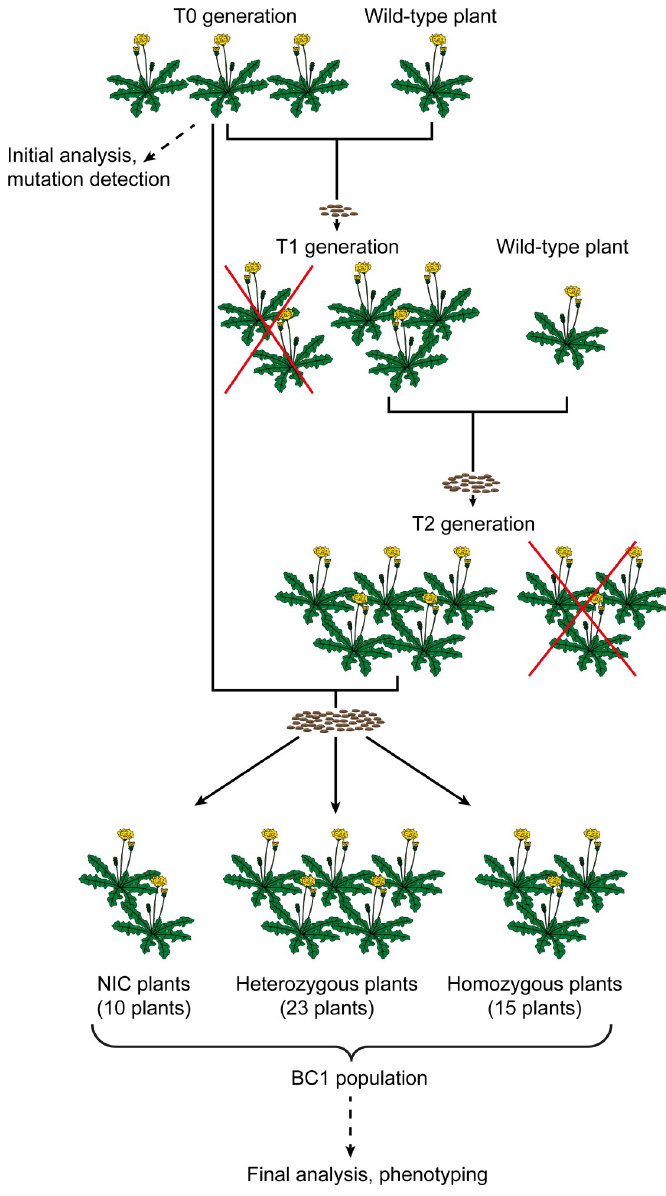
Fig 5. Crossing scheme for the generation of the backcross population. T0 plants were generated by stable Agrobacterium -mediated transformation, genome editing was analysed and plants were subsequently pollinated with a compatible T . koksaghyz wild-type plant, resulting in T1 plant families. T1 plants carrying desired mutations (not segregated out) were pollinated with another compatible T . koksaghyz wild-type plant, resulting in the corresponding T2 plant families. Plants of the T2 generation carrying desired mutations (not segregated out) were pollinated with the T0 plants, resulting in BC1 offspring consisting of 10 NIC plants, 23 heterozygous and 15 homozygous knockout plants. BC1, backcross generation 1.